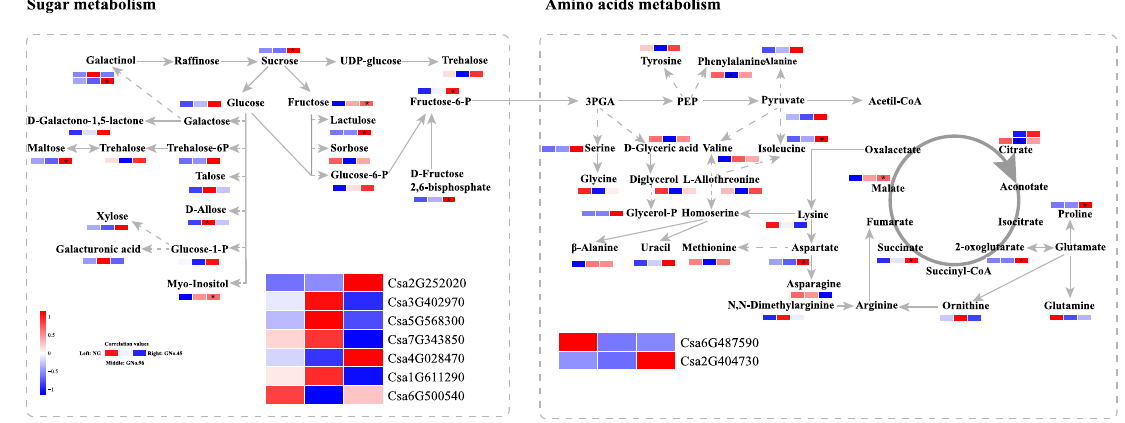
Figure 7. Metabolic profile analyzed by gas chromatography tandem time-of-flight mass spectrometry (GC-TOFMS), and the gene expression pattern analyzed by metabolism-gene correlations. The points within each graph indicate significant differences ( p < 0.05).